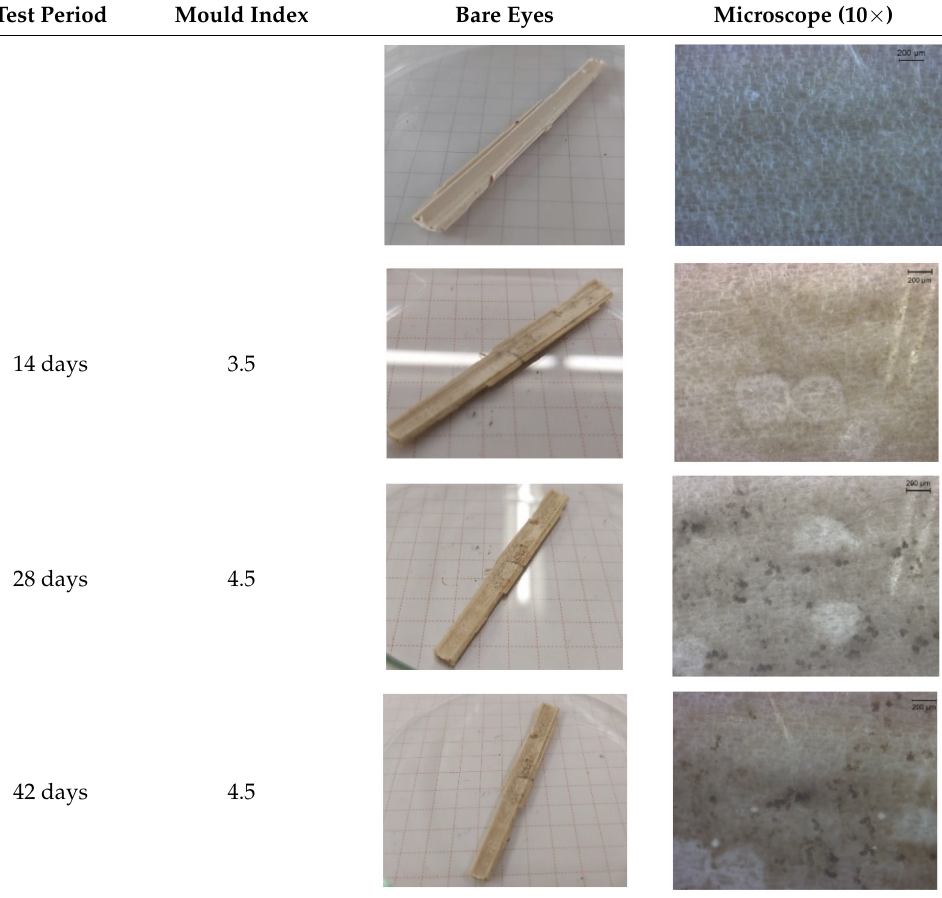
Table 5. Development of surface moulds in G1 dry